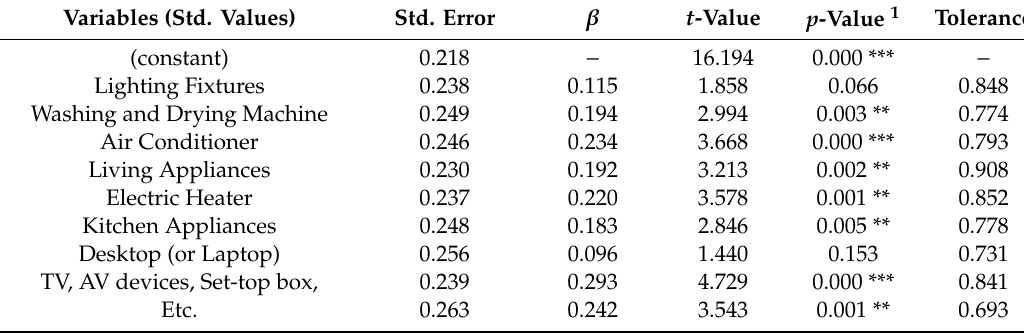
Table 8. Result of Regression Model II.